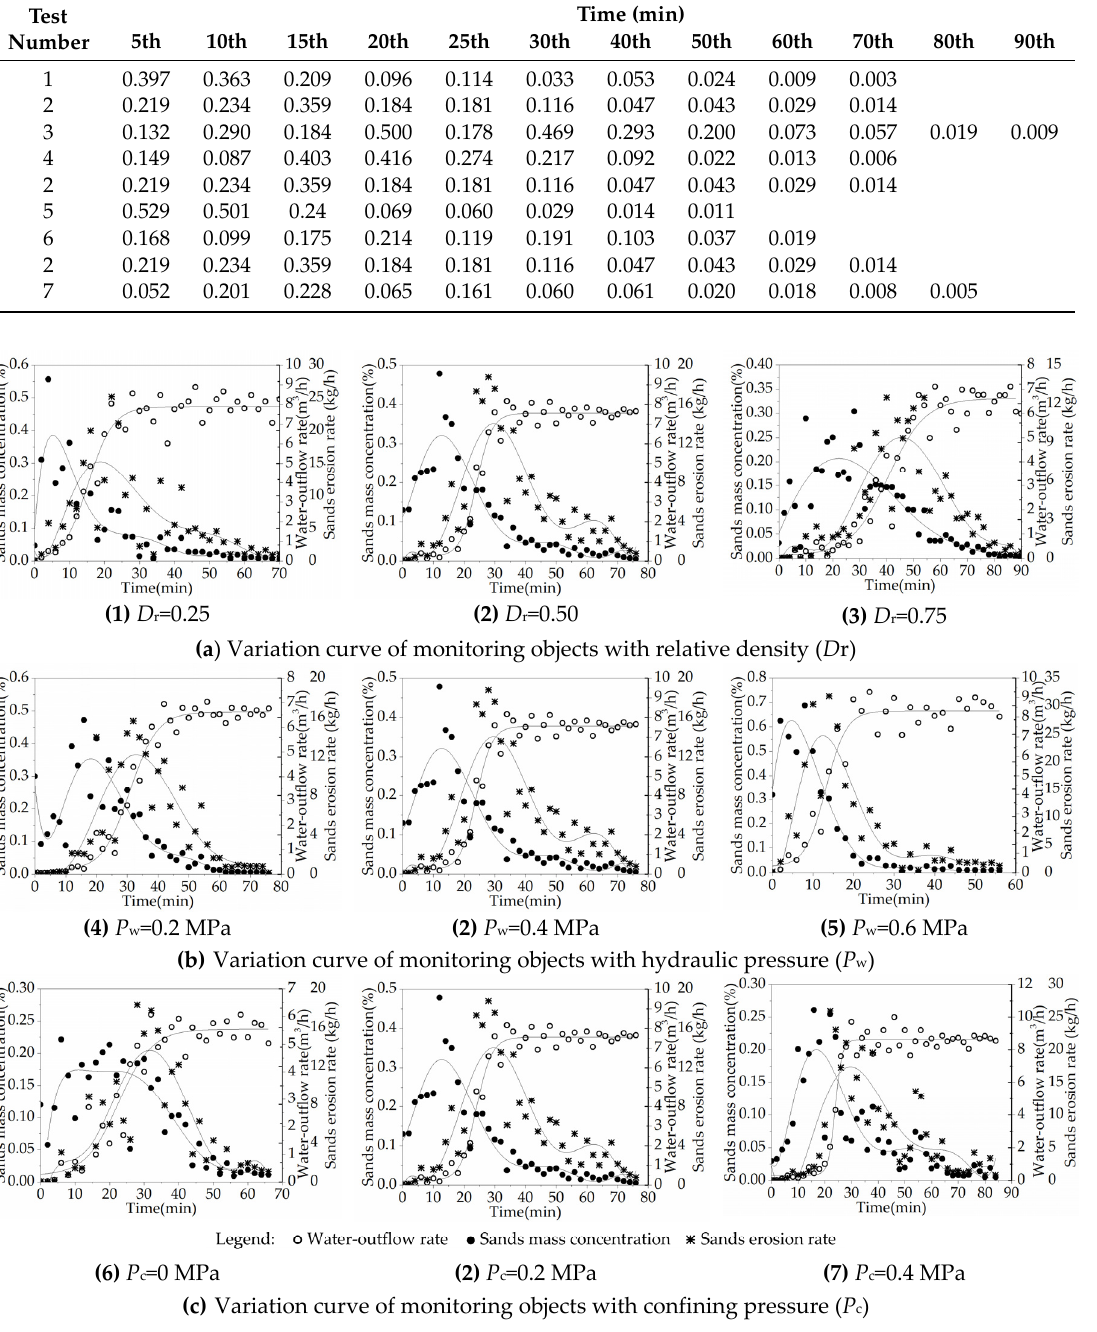
Figure 6. The variation tendency of monitoring objects with influence factors.